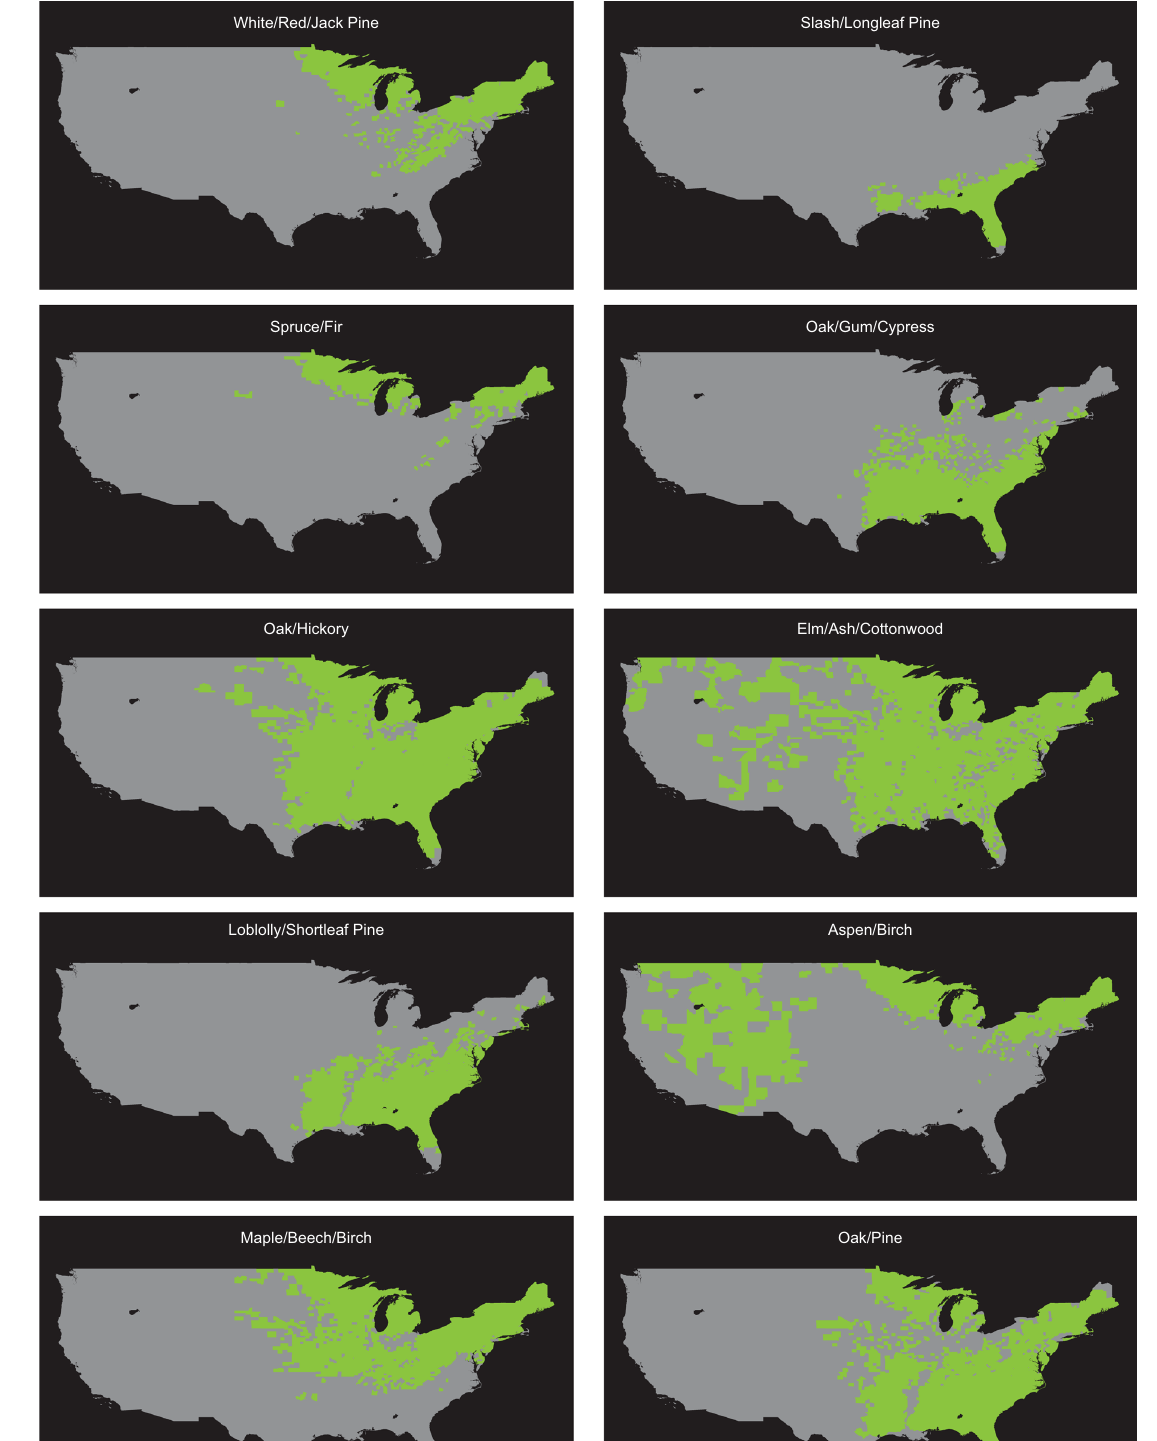
Fig. 2 | Geographic range of forest groups based on observations taken by USFS. Note:This fi gureforeachforestgroupdetails(ingreen)allcountiesinwhich the US Forest Service Forest Inventory and Analysis (USFS-FIA) database has